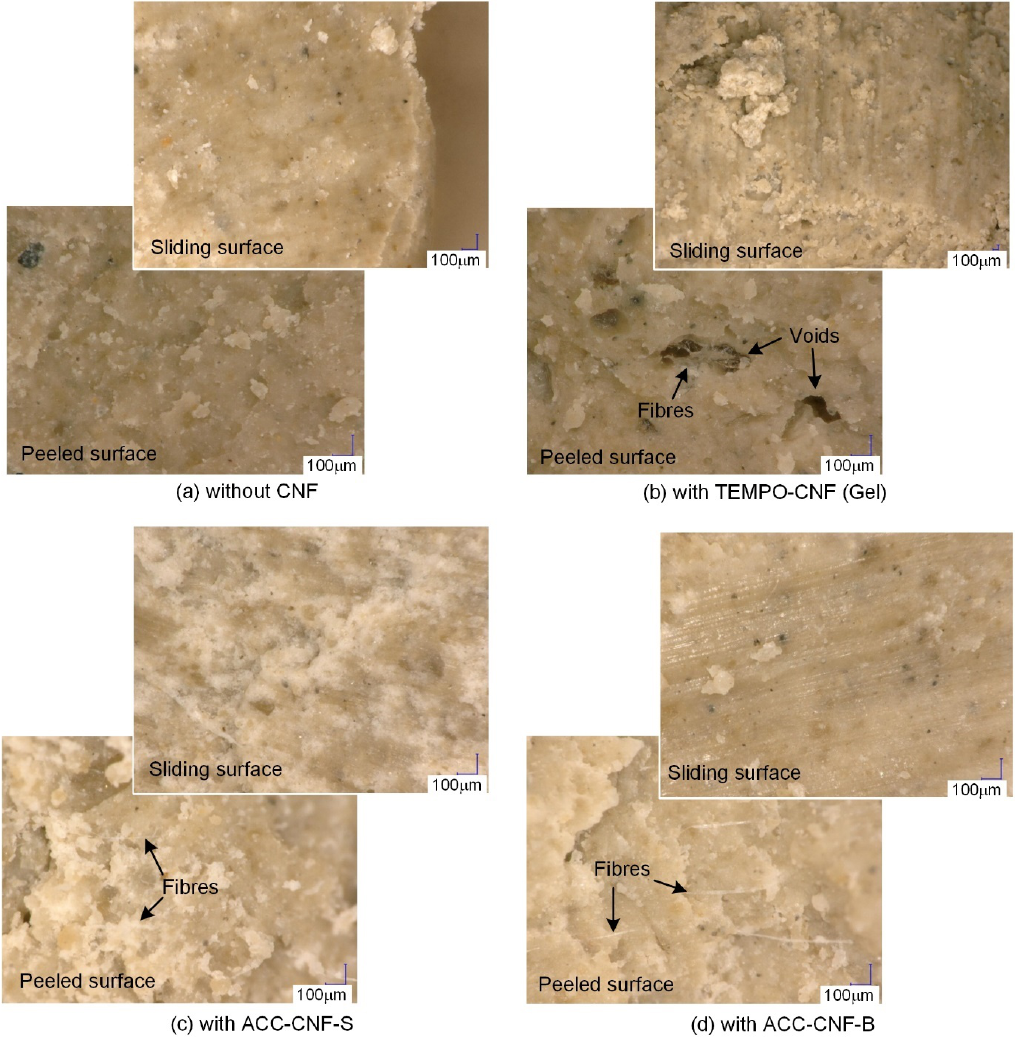
Figure 7. Appearance of sheared surface (Method 1).